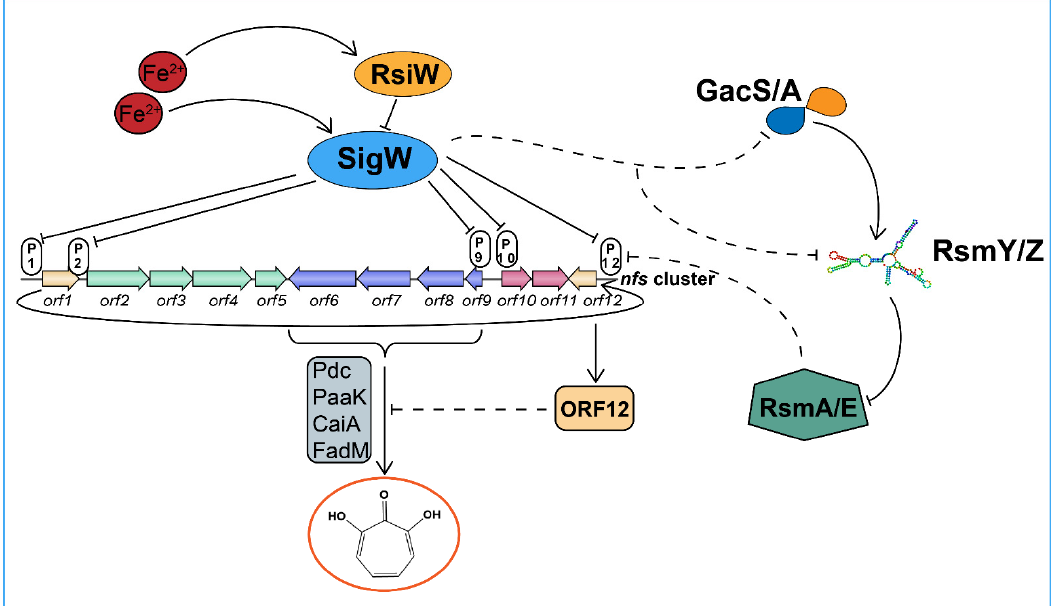
Figure 9. Schematic overview of the regulatory network of SigW/RsiW in P. donghuensis HYS. The T-shaped lines represent the negative control, the arrows represent the positive control, the solid lines highlight the existence of an already demonstrated regulation, and the dotted lines indicate the connections that were not confirmed in this work. P1, P2, P9, P10, and P12 represent the promoters of the five operons in the nfs cluster, respectively. ORF6, ORF7, ORF8, and ORF9 encode the Pdc, PaaK, CaiA, and FadM family proteins, respectively, which catalyze the key reaction of 7-HT biosynthesis.